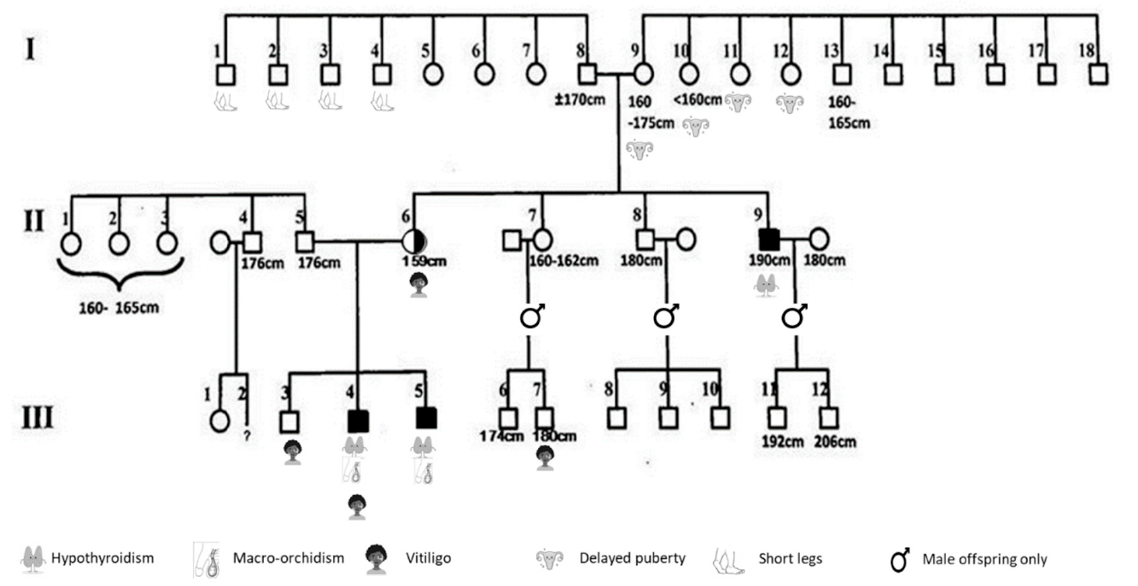
Table 5. The most remarkable observations found in the two brothers and their relatives are described below.